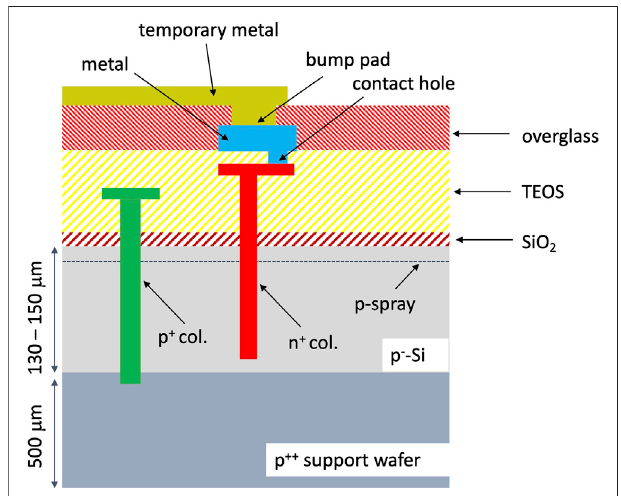
FIGURE 1 | Schematic cross-section of 3D small-pitch pixels made at FBK on Si-Si substrates with a single-sided technology (not to scale). The same process is also used for 3D trenched